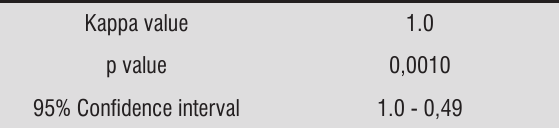
Table 2. Medians distribution of examiners scores do